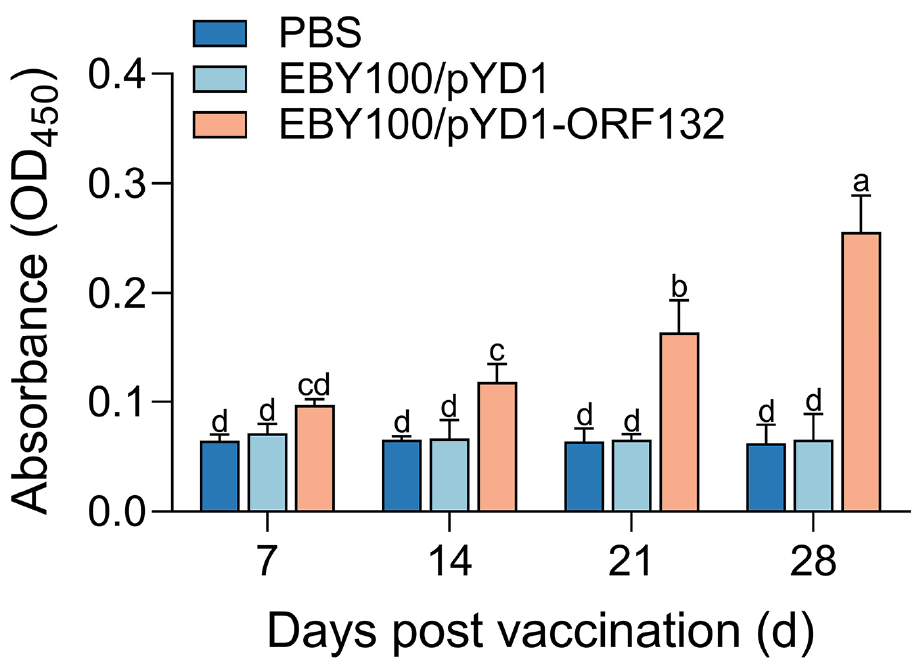
Figure 2. ORF132 specific antibody induced by oral vaccination. Fish serum from crucian carp was collected on day 7, 14, 21, and 28, and the antigen-specific immune responses were analyzed by ELISA. Bars with different letters were significantly different according to the Duncan’s multiple range ( p < 0.05).